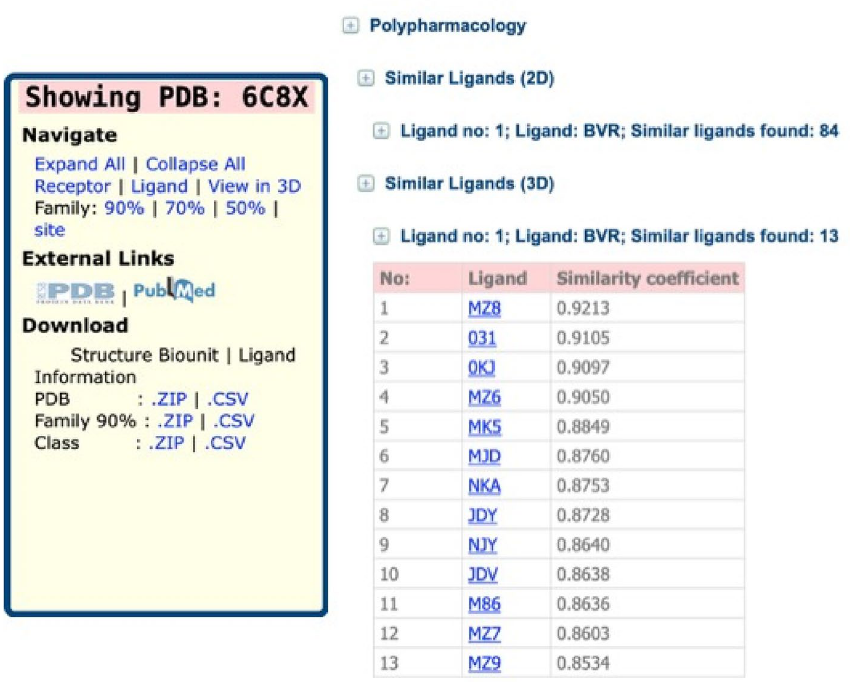
Figure 1. Example of the 3D similarity of an entry on BindingMOAD.org.